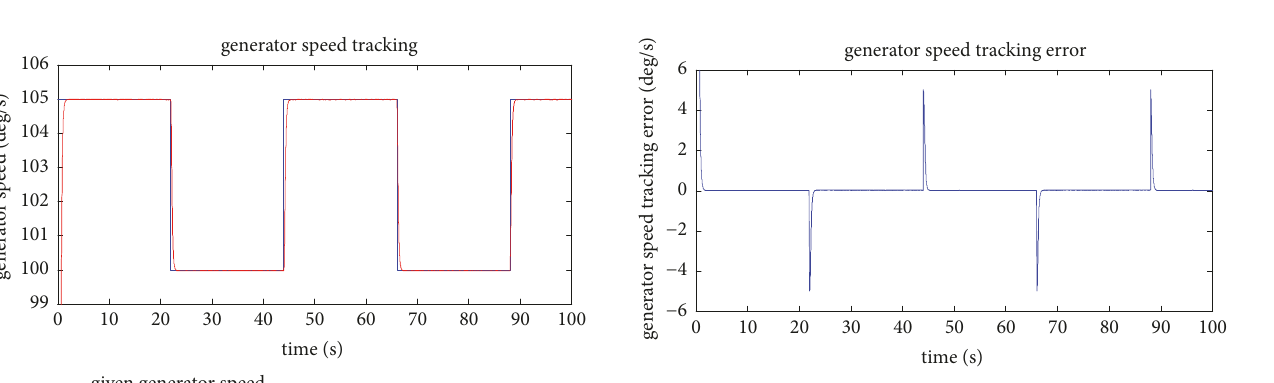
Figure 8: Generator speed tracking error with IVSC. structure control is adopted for generator speed tracking. Tracking control with better precision is